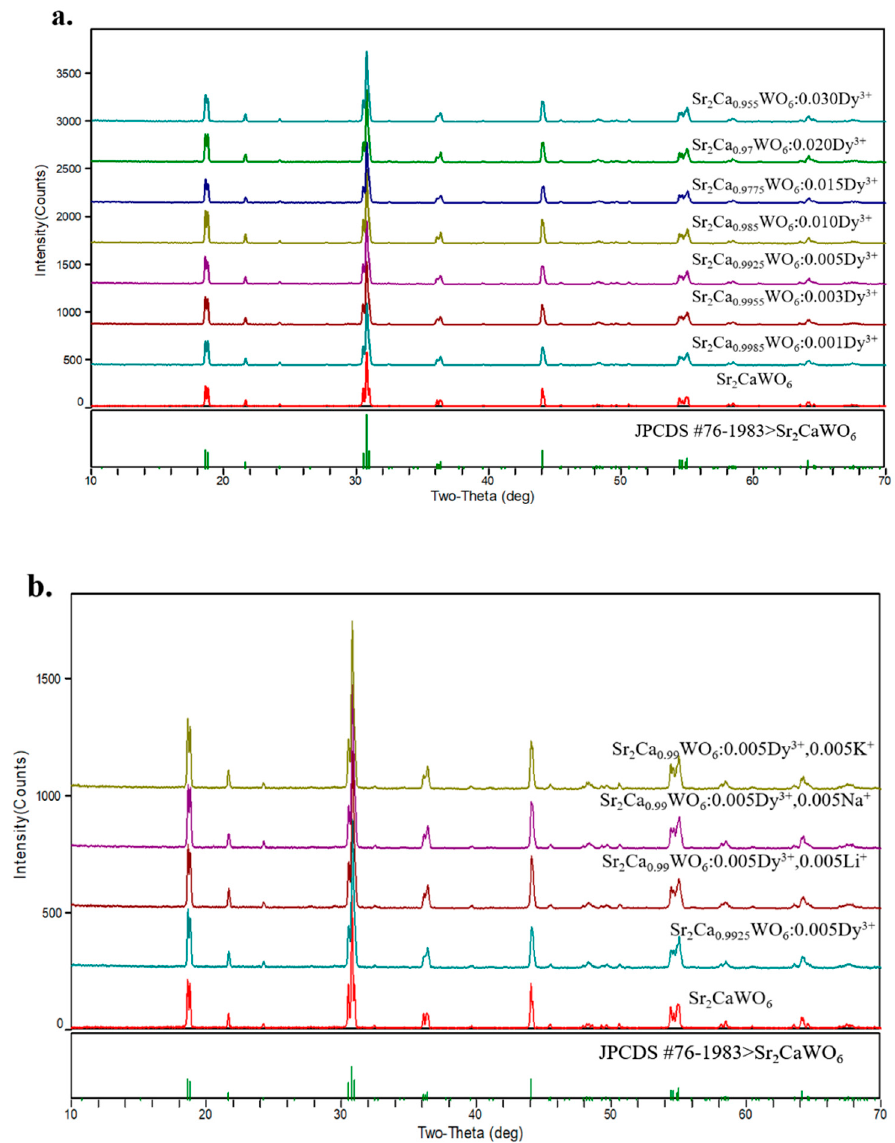
Figure 1. ( a ). The X-ray diffraction patterns of Sr 2 Ca (1 − 1.5x%) WO 6 : x mol%Dy 3+ ( x = 0, 0.1, 0.3, 0.5, 1.0, 1.5, 2.0, 3.0); ( b ). The X-ray diffraction patterns of Sr 2 CaWO 6 , Sr 2 Ca 0.9925 WO 6 : 0.5 mol% Dy 3+ and Sr 2 Ca 0.99 WO 6 : 0.5 mol% Dy 3+ , 0.5 mol% M + (M + = Li + , Na + , or K + ).